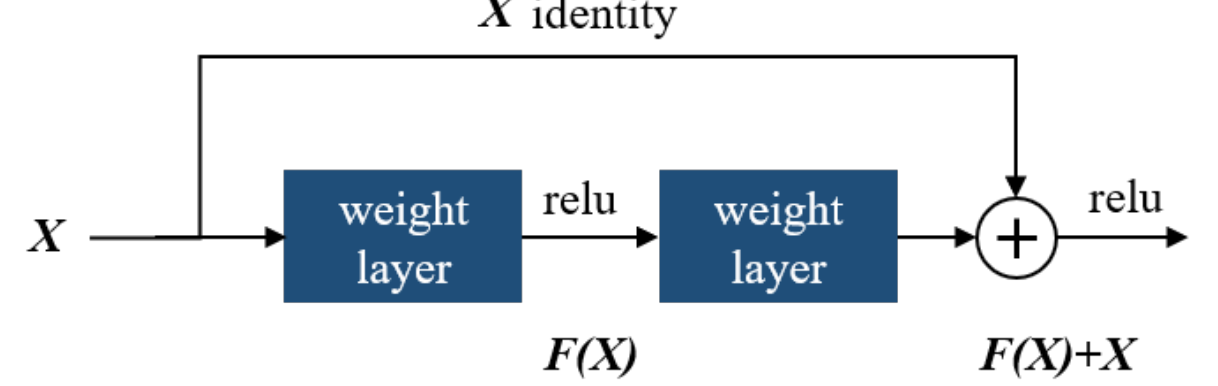
Figure 18. Showing the residual identity mapping for a residual neural network.